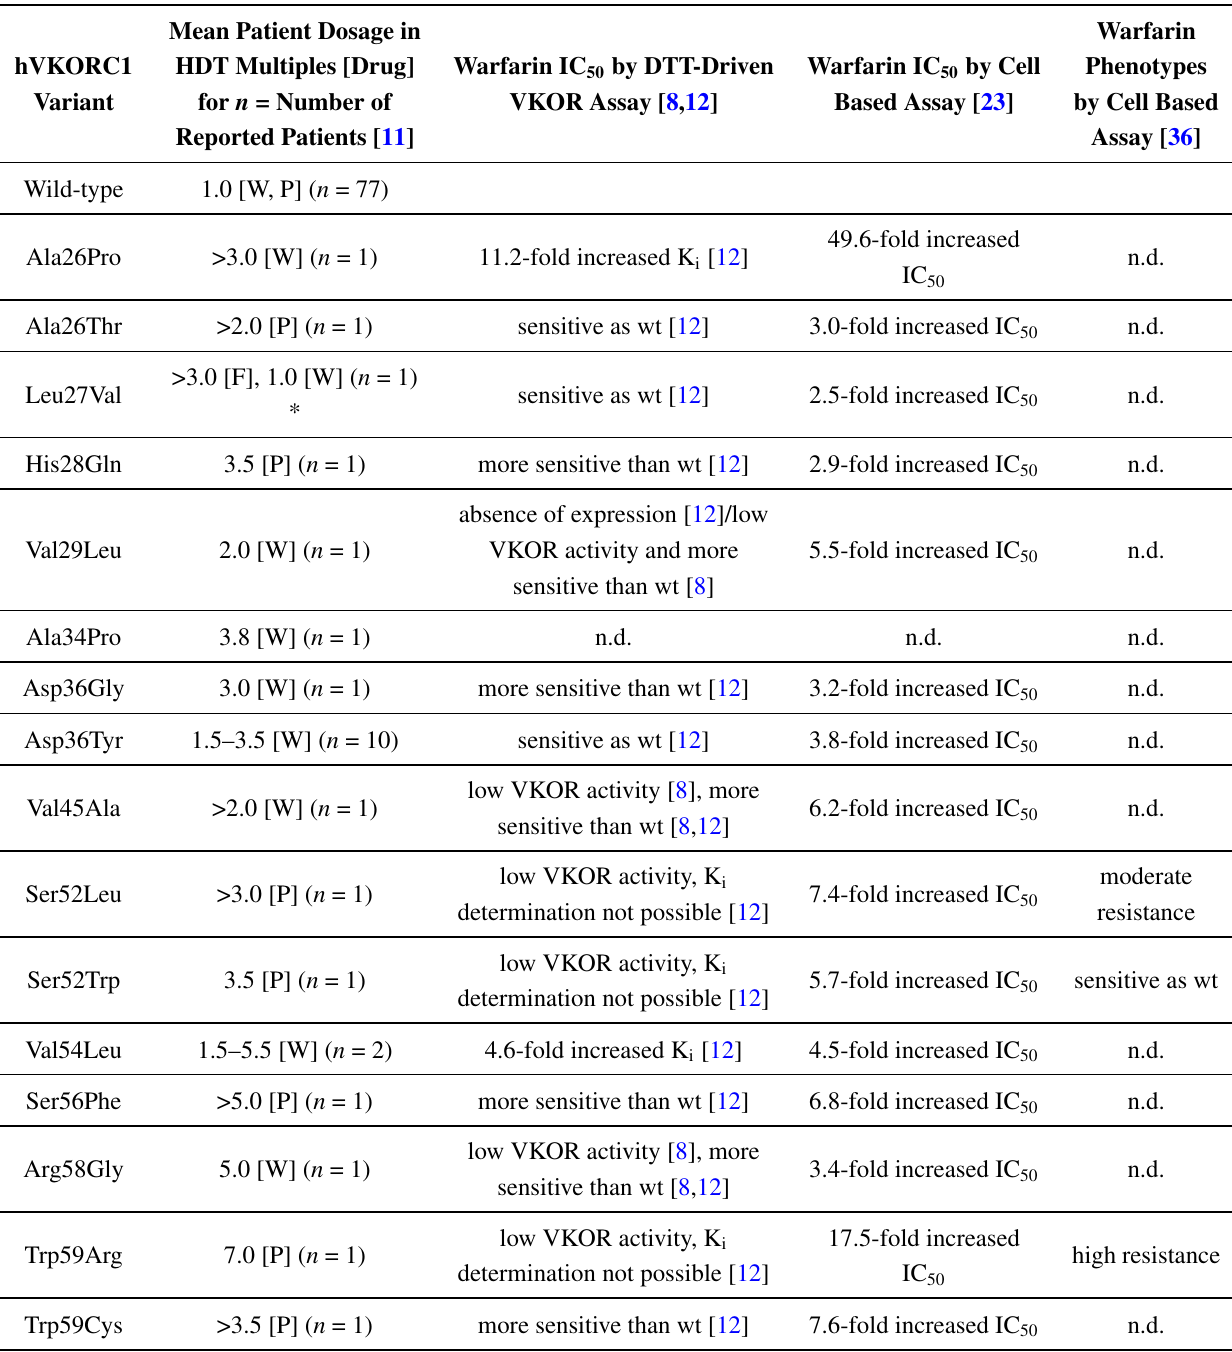
Table 3. Comparison of warfarin inhibition for hVKORC1 variants determined by in vitro assays of vitamin K 2,3-epoxide reductase (VKOR) in cell fractions or in cultured